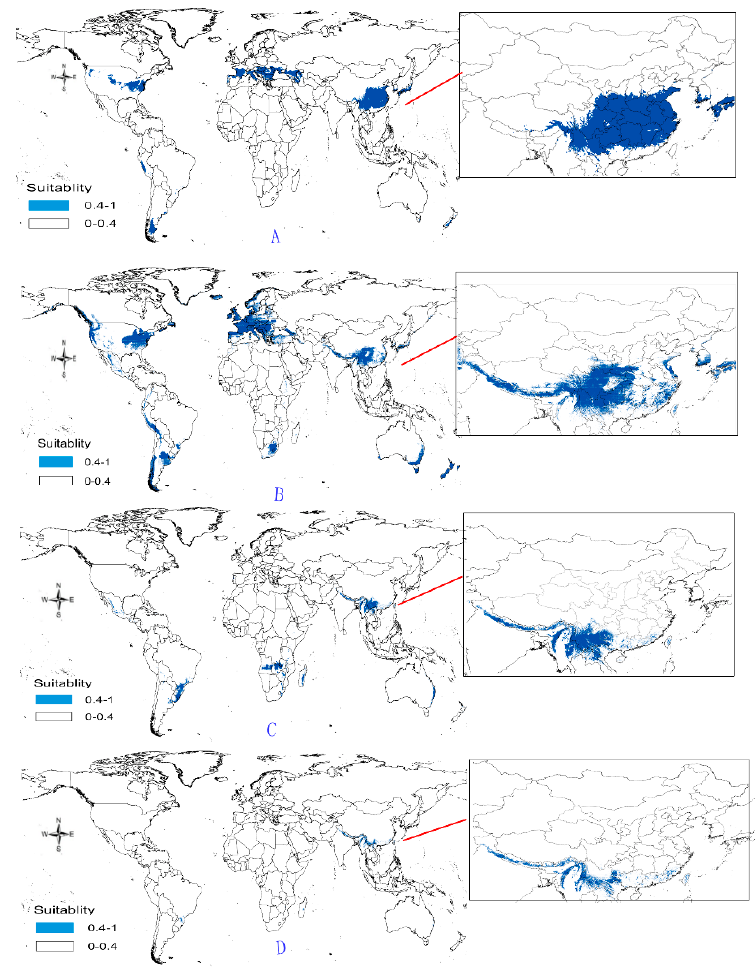
Figure 7. Spatial distribution map of potential distribution for four endangered Panax species based on MaxEnt. ( A : P. japonicas ; B : P. japonicus var. major ; C : P. zingiberensis ; D : P. stipuleanatus ).